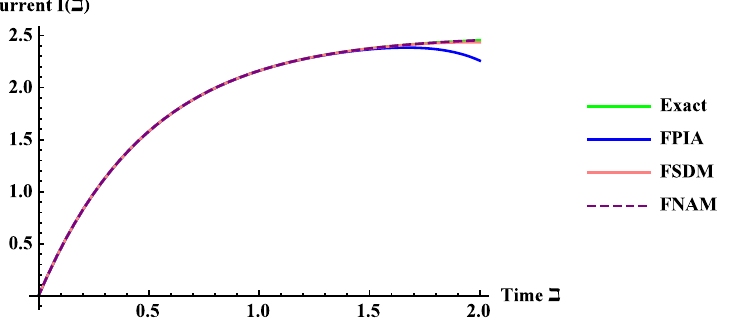
Figure 7. Graphical comparisons of classical solution and approximate solutions of the inductor– resistor circuit at α = 1, R = 4, L = 2, E 0 = 10, and i 0 = 0.